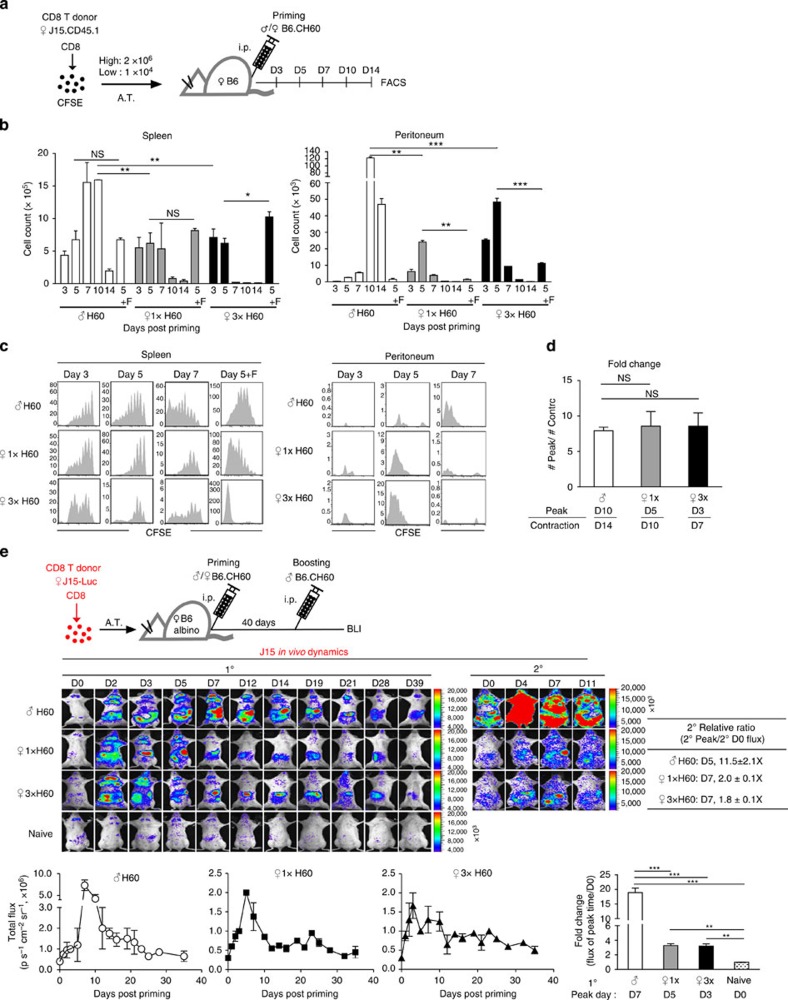
Dynamics of H60-specific CD8+ T cells under different conditions.(a) J15 CD8+ T cells were harvested from the spleen and peritoneum of adoptive hosts at the indicated times after exposure to different priming conditions, (b) quantified and (c) analysed by flow cytometry to compare CFSE-dilution profiles. Numbers and CFSE profiles of J15 CD8+ T cells from FTY-720-treated mice were obtained on day 5 post priming and were incorporated in plots designated as day 5+F in (b,c). (d) Contraction degrees (peak numbers/contraction numbers) of splenic J15 CD8+ T cells obtained from adoptive hosts are plotted. Data shown were obtained from adoptive hosts transferred in high numbers (b–d). (e) Dynamics of J15-LucTg CD8+ T cells in B6-albino-adoptive hosts (transferred with 1 × 105 cells) were monitored periodically after priming under different conditions through secondary expansion. Those in B6-albino-adoptive hosts without priming are also shown as control (naive). Photon flux values as the primary responses progressed were plotted after designating the whole body as the ROI. Fold changes in peak values in 1o peak relative to the values of 1o day 0 (before priming) are shown. The mean relative ratios of 2o peak: 2o day 0 (before boosting) photon flux values are presented in the table. Data shown represent at least three (n=2 per group; b–d) or two (n=3 per group; e) independent experiments. A.T., Adoptive Transfer. Data are presented as means±s.e.m. Not Significant (NS) P>0.05, *P<0.05, **P<0.01, ***P<0.001 determined by Student's t-test.